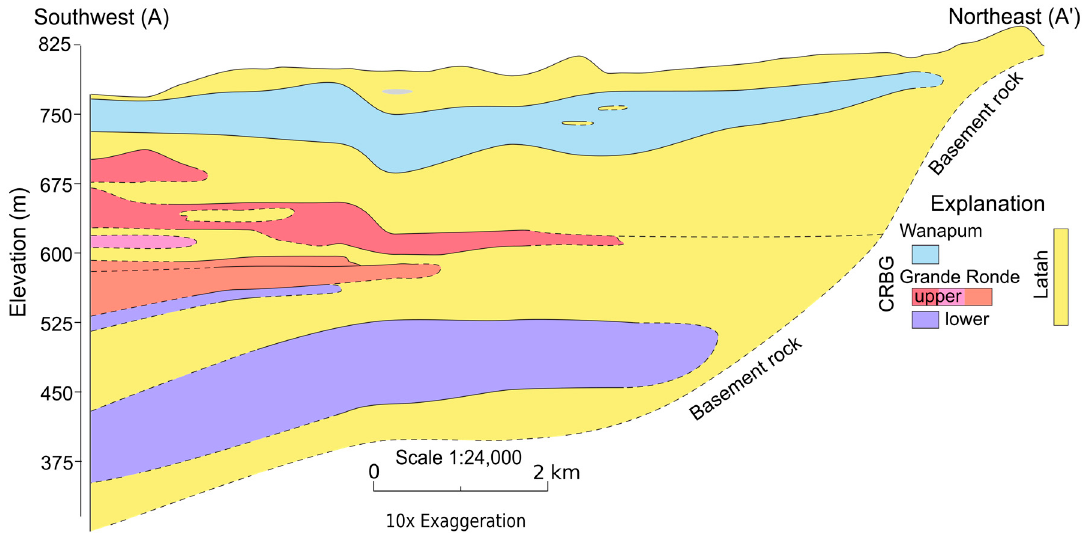
Figure 2. Southwest-to-northeast cross section (A–A’, Figure 1) of the eastern South Fork Palouse River Basin near Moscow, Idaho, USA (modified from Bush et al. [9]).